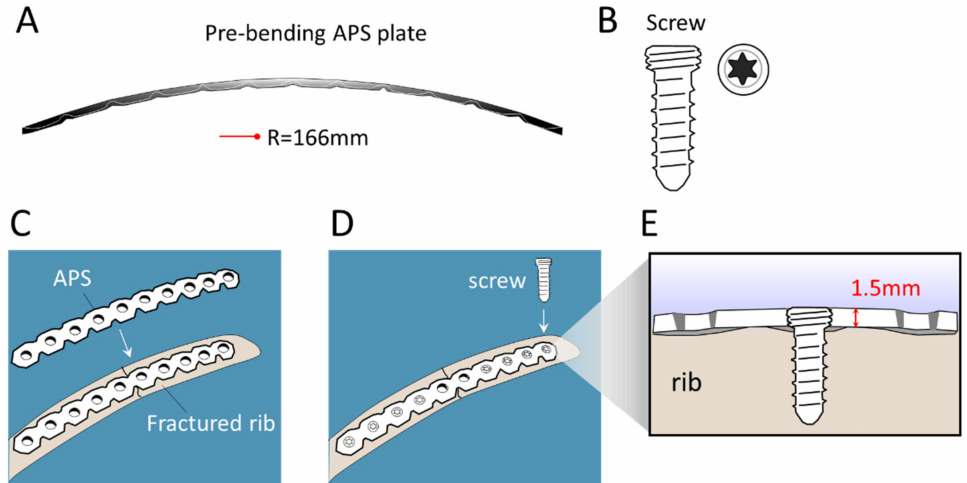
Figure 1. Schematic illustration of the configuration of the APS Rib Fixation System and its implanta- tion in the scenario of repairing a rib fracture. ( A ) Sagittal view of APS plates shows a “pre-contoured” shape to fit an average rib shape, minimizing the need for intraoperative bending. R = radius. ( B ) The APS screw. ( C , D ) The procedure of implanting an APS plate on a bone injury. ( E ) The cross-sectional view of a screw-locked 1.5 mm thick APS plate.